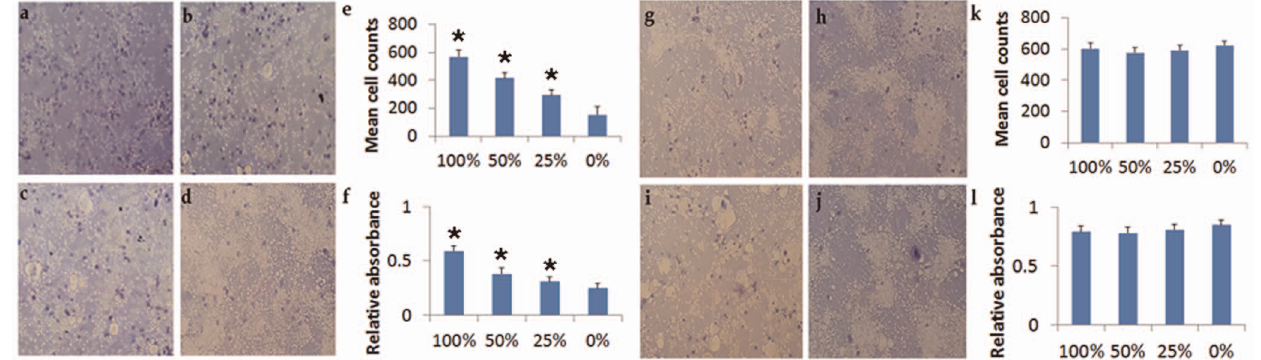
Figure 3. DPC co-culture protects rat neural cells against OGD. Co-culture of rat primary neural cells with DPCs afforded neuroprotection against OGD dose-dependently in both Trypan blue and MTT activity assays of cell viability (a–f). The percentages correspond to the ratio of DPCs co- cultured with rat primary neural cells as follows: 1:1 (100%), 1:2 (50%), 1:4 (25%), and 1:0 (0%). DPCs co-cultured with rat primary neural cells under non-OGD condition did not alter cell viability in both assays (g–l). Asterisk* corresponds to statistically significant difference (p , 0.05 vs. 0%). a,g: 0%; b,h: 25%; c,i: 50%; d,j: 100%; e,k: Trypan blue stain quantification; f,l: MTT assay quantification.